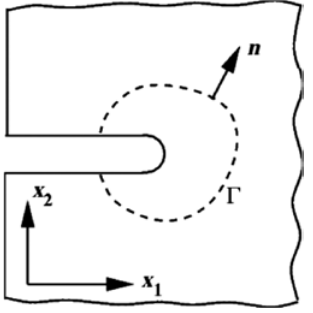
Figure 5: Contour of the equivalent von Mises stress to the fiber orientations of 30 ° in the case of the